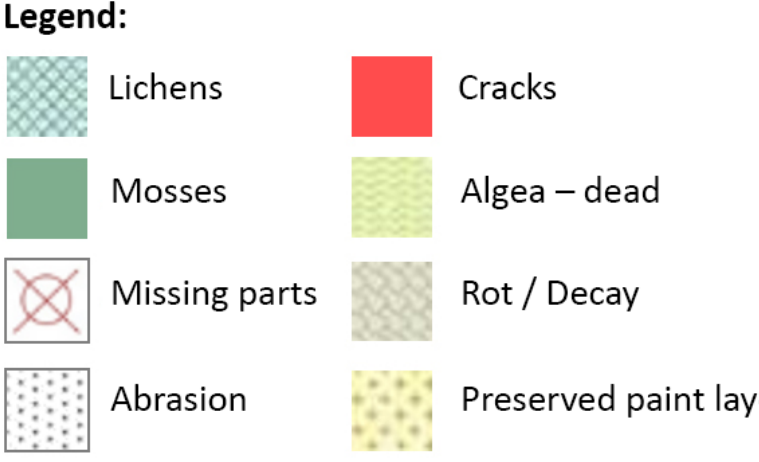
Figure 5. The texture before and after the applied hatches (mentor: prof. dr. Denis Tr č ek; author: Ana Sterle).